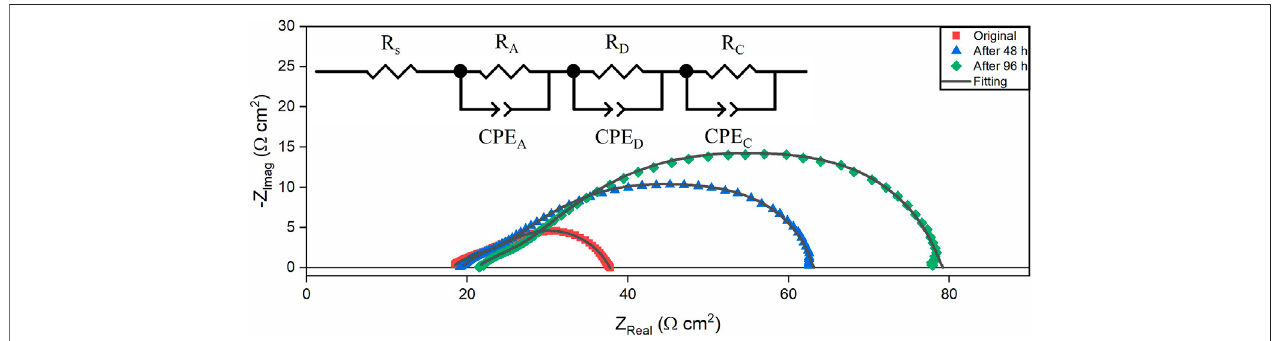
Frontiers in Energy Research |